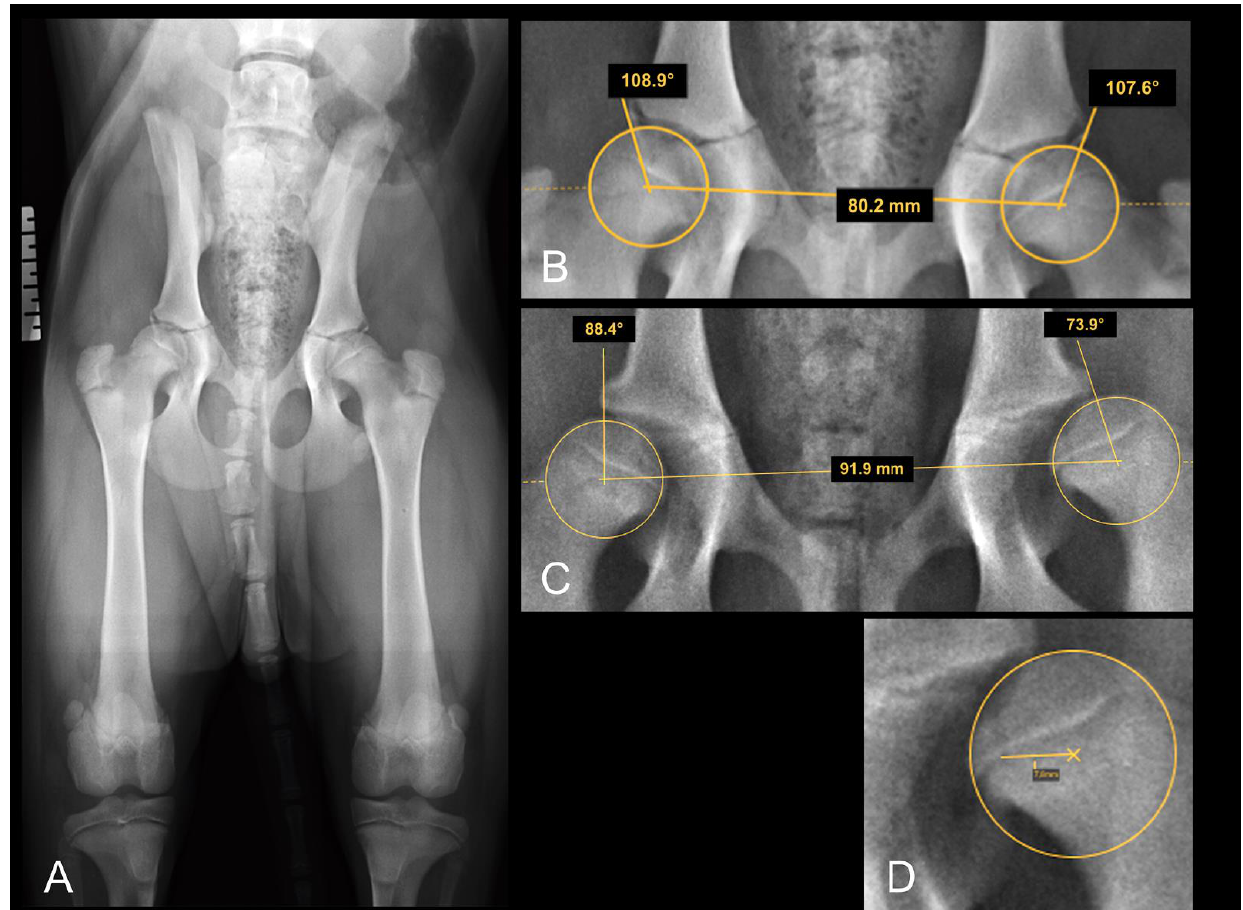
Figure 1. ( A ) Extended FCI conform ventrodorsal radiograph of a four-month-old Rottweiler with what were assumed to be normal hip joints. Note the transitional lumbosacral vertebrae (type III). Right is always to the left of the images. ( B ) Magnification of ( A ), focusing on the hip joints: demon- stration of Norberg angle measurement. ( C ) Section of a VD radiograph in another four-month-old Rottweiler puppy with obvious laxity of both hip joints, more severe on the left side. The femoral head center is positioned on, or barely medial to, the dorsal acetabular rim in ( B ) and definitely lateral to the DAR in ( C ) bilaterally. ( D ) Magnification of ( C ), demonstrating the actual distance of the femoral head center from the DAR. 2.5.2. Sclerosis of the Cranial Acetabular Rim (SCAR) The SCAR was investigated according to its uniformity and thickness and was cate- gorized as regular and thin sclerosis (normal), regular and thick sclerosis, or laterally in- creased thickness of sclerosis (abnormal). 2.5.3. Location of the Center of the Femoral Head (LCFH) The LCFH was evaluated according to its position relative to the dorsal acetabular rim (medial, on, or lateral). The results were categorized as medial to DAR, superimposing DAR, 0 – 2 mm lateral to DAR, and more than 2 mm lateral to DAR (Figure 1). 2.5.4. Grading of the Degenerative Joint Disease (GDJD) The grading of the DJD of the coxofemoral joint was based on the evaluation of the joint space and the existence of the osteophytes. The results were classified as hips with